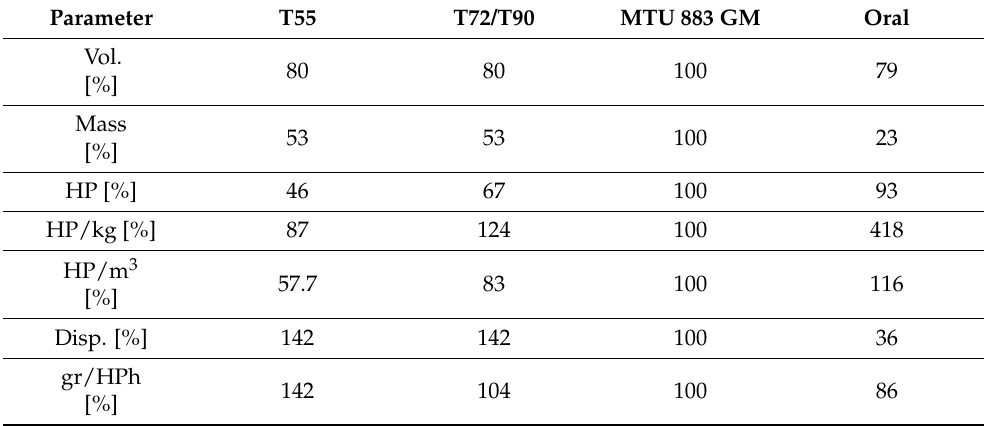
Figure 8. SHEV power pack and transmission with dual drive for a large MBT; (1) engine; (2) generator(s); (3) motors of right sprocket; (4) motors of left sprocket; (5) final reduction and sprocket right side; (6) final reduction and sprocket left side. Table 3. % Comparison of several MBT Engines. The reference engine is the MTU 883 GM.